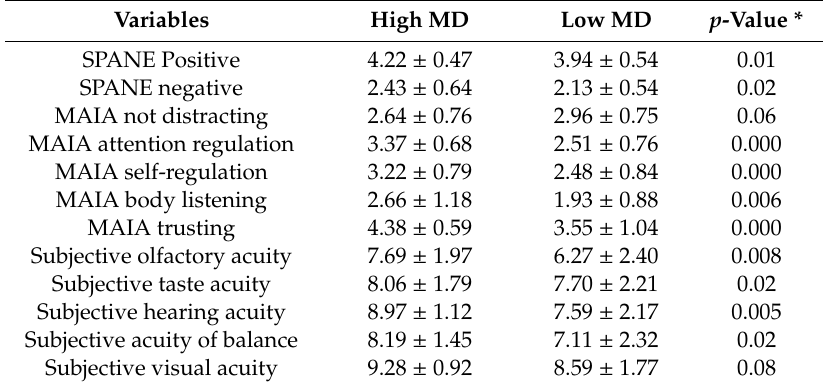
Table 2. Summary of MD profile on psychological assessments (mean ± standard deviation).